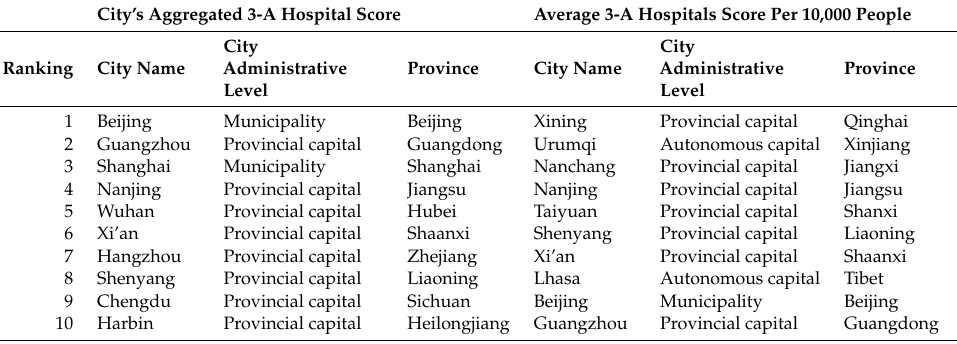
Table 3. Top 10 Cities Ranked by City’s Aggregated 3-A Hospital Score vs. Average 3-A Hospitals Score Per 10,000